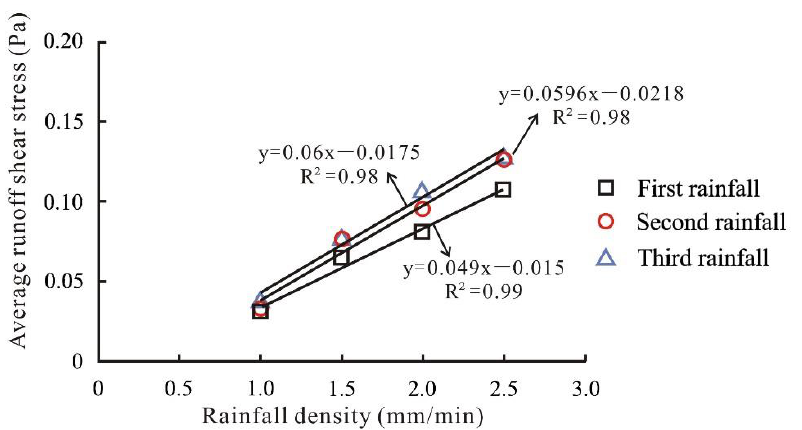
Figure 22. Linear fitting relationship between average runoff power and rainfall density of the loess slope.